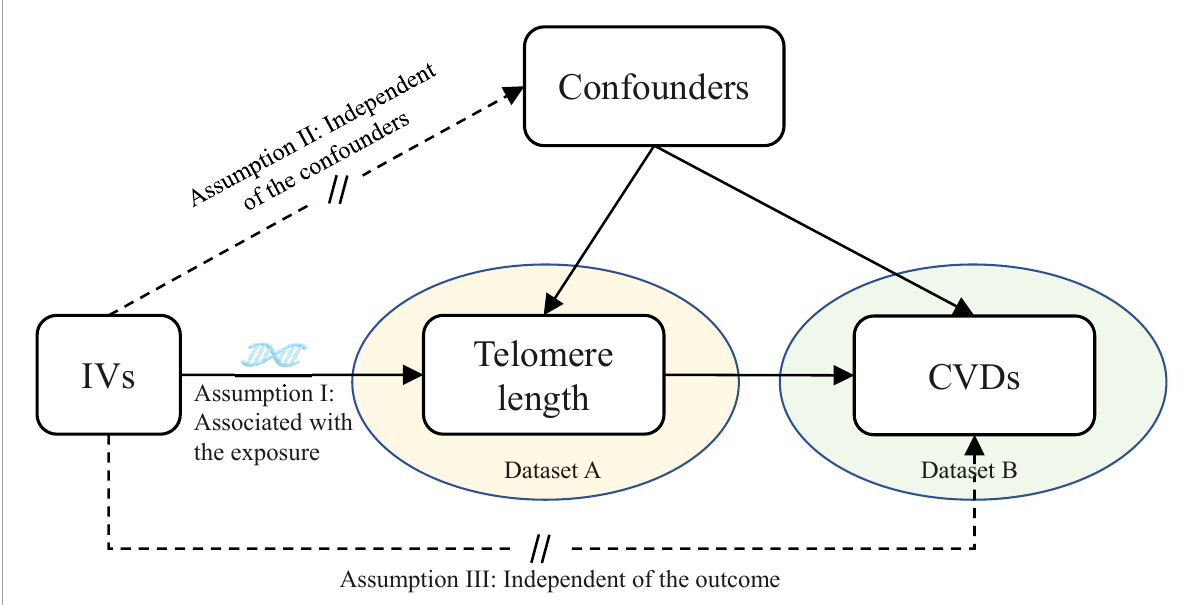
FIGURE1 Assumptions of the Mendelian randomization (MR) analysis for TL and the risk of CVDs. The MR study assumes that genetic variants are associated with only TL and not with confounders or alternative causal pathways, that is, the IVs affect the risk of CVDs only directly through TL. TL, telomere length; CVDs, cardiovascular diseases; IVs, instrument variables.